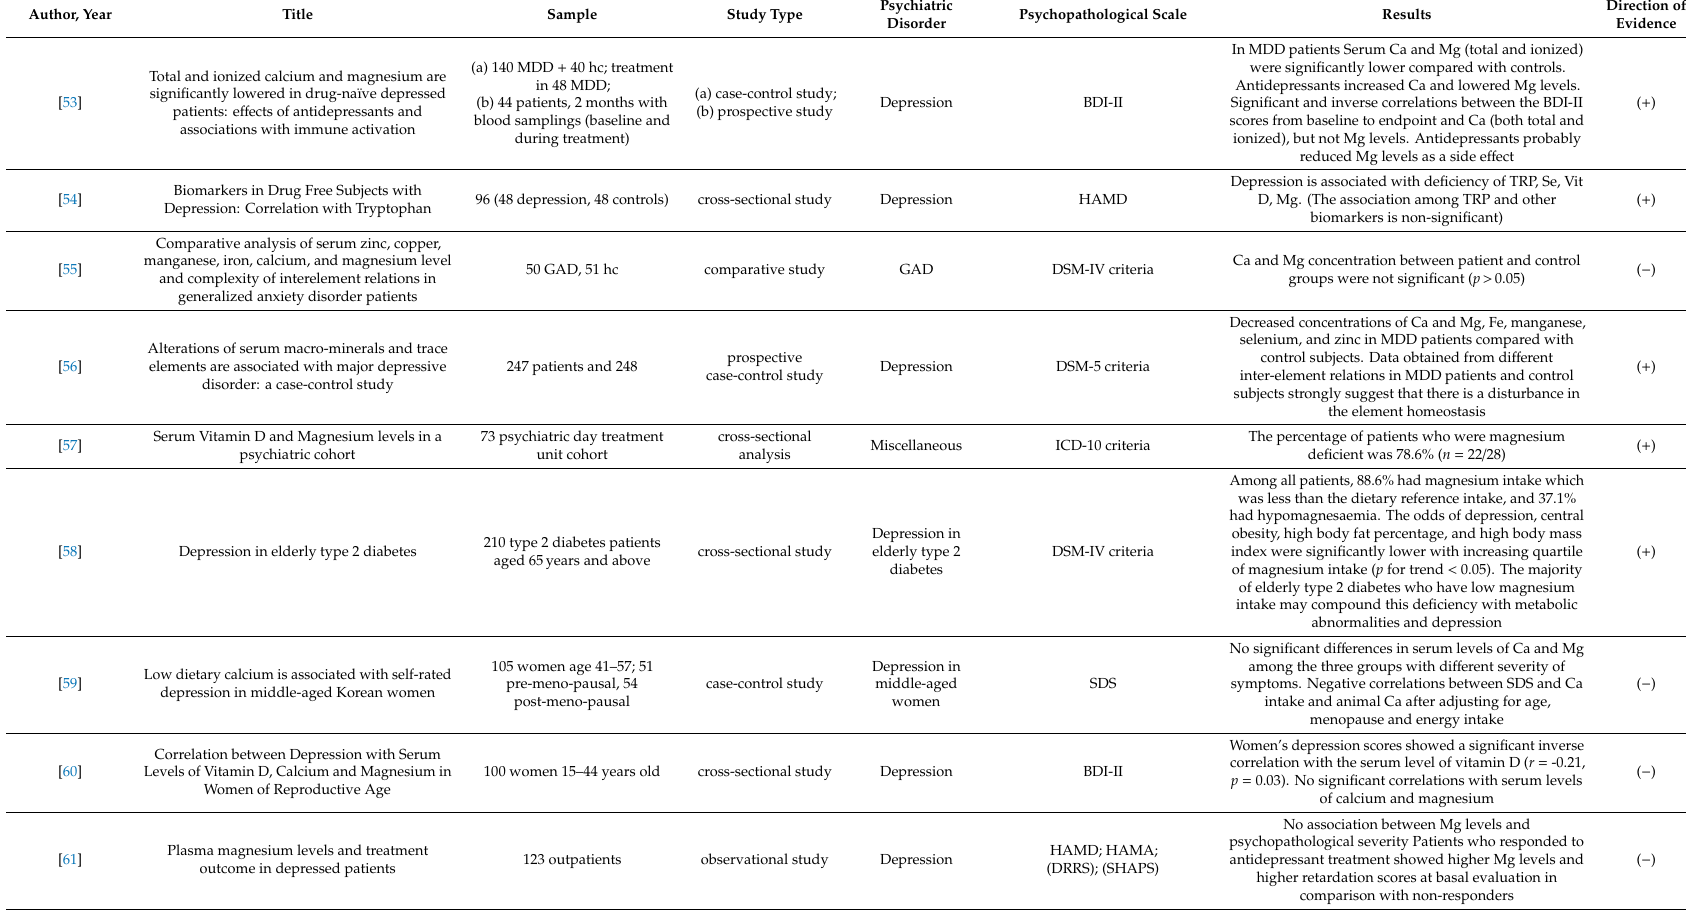
Table 1. Studies of magnesium